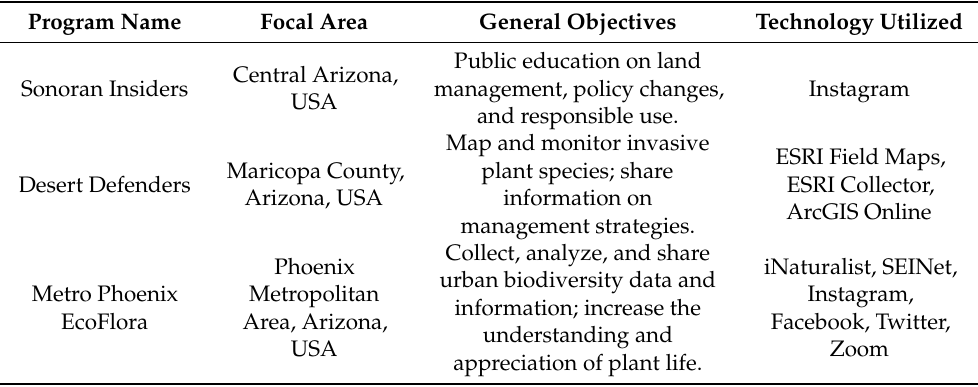
Table 1. CAZCA programs explored in this case study in order of